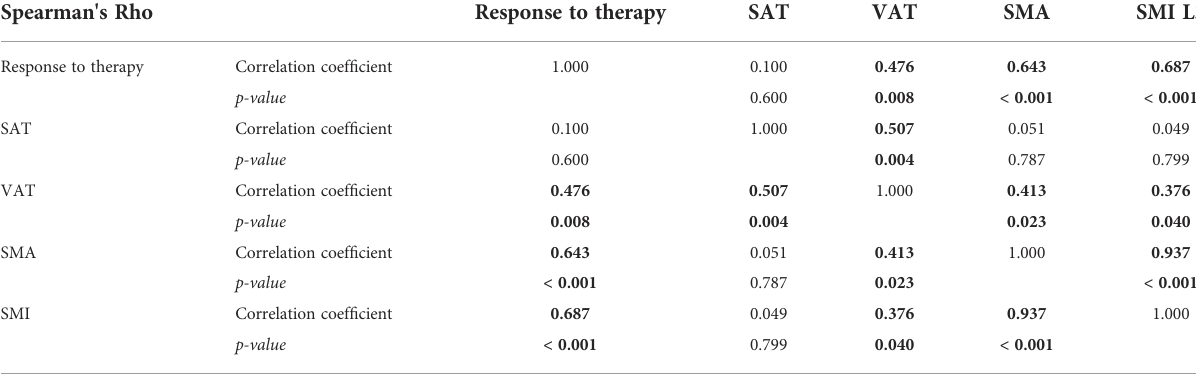
TABLE 2 Statistical correlation between response to therapy and body composition parameters. Spearman's